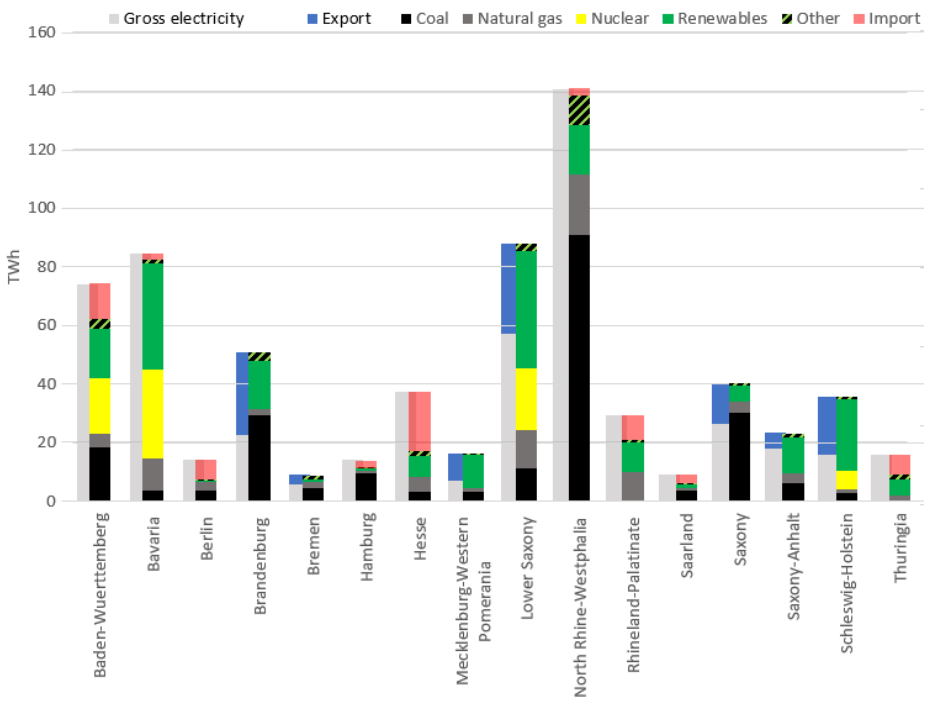
Figure 4. Generation, consumption, and physical import and export balances of the German states in 2018 in TWh. Values were calculated based on gross electricity generation profiles from the Federal Office of Statistics, https://www.destatis.de (accessed on 20 August 2021), renewable energy parts are available at https://www.foederal-erneuerbar.de (accessed on 20 August 2021), and net currents are taken from the Federal Network Agency and Federal Cartel